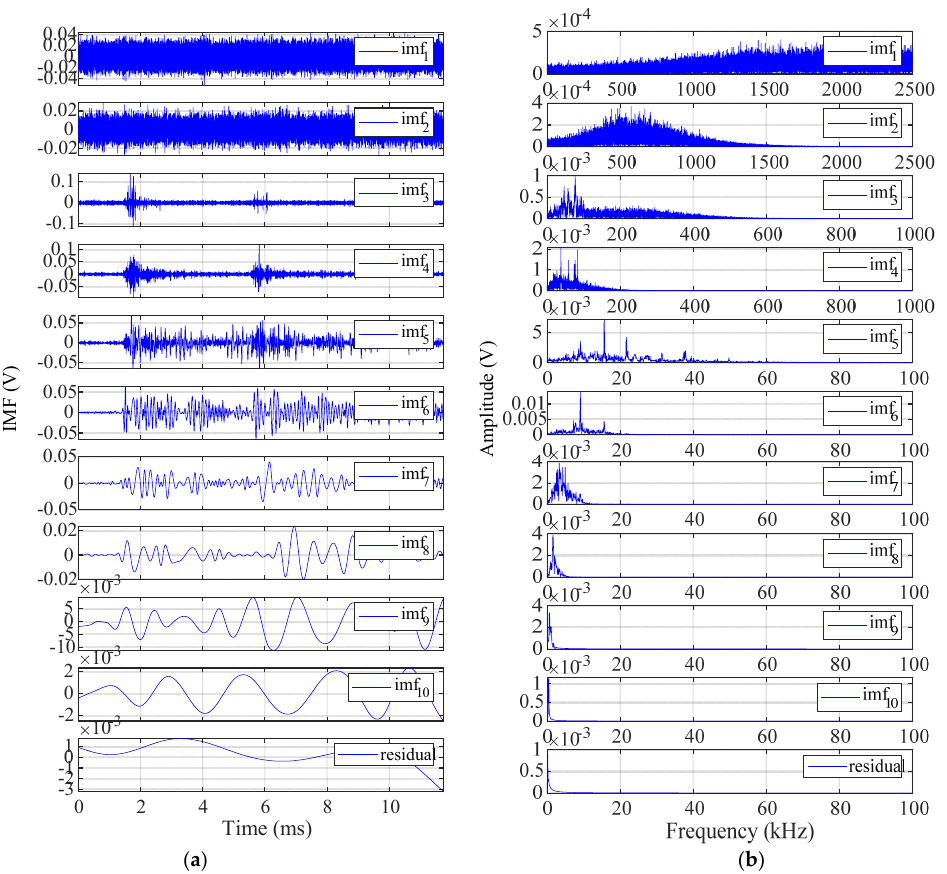
Figure 15. EMD results: ( a ) decomposed components of EMR waveform; ( b ) Fourier spectra of decomposed